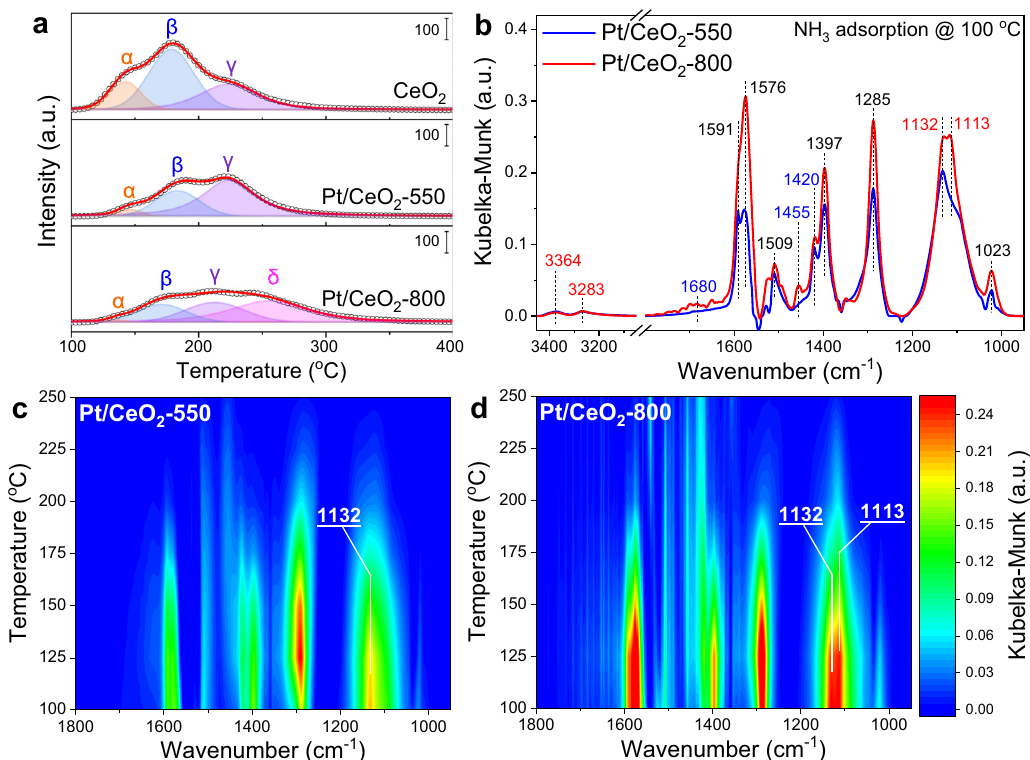
Fig. 8 | NH 3 adsorption properties of Pt 1 /CeO 2 catalysts. a NH 3 -TPD pro fi les on CeO 2 , Pt/CeO 2 -550, and Pt/CeO 2 -800; b in situ DRIFTS of NH 3 adsorption at 100°C; in situ DRIFTS of NH 3 adsorption and desorption on c Pt/CeO 2 -550 and d Pt/CeO 2